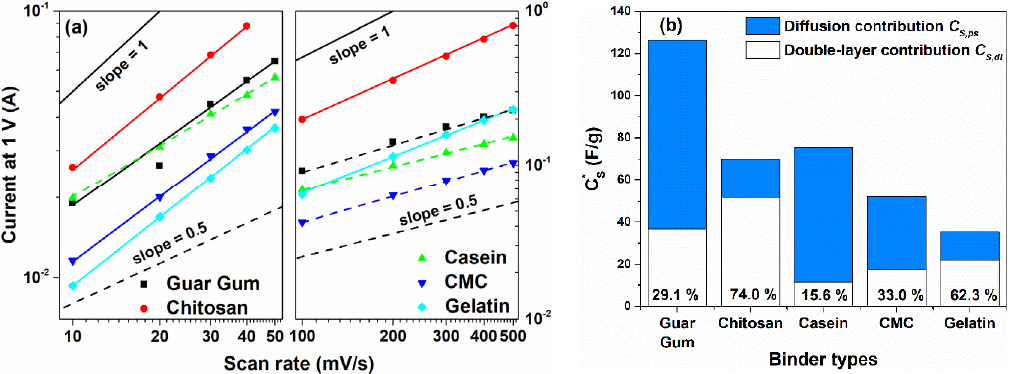
Figure 4. ( a ) Dependence of the current values measured at 1 V for the binders used in the carbon electrode at lower ( left y-axis) and ( right y-axis) intermediate scan rate regions, respectively; ( b ) Contribution of pseudocapacitance (diffusion-limited) and double layer capacitance (surface-limited) to the overall capacitance C ∗ for all the binders investigated. Solid and dashed lines are referred to the capacitive and diffusion-controlled mechanisms, respectively.